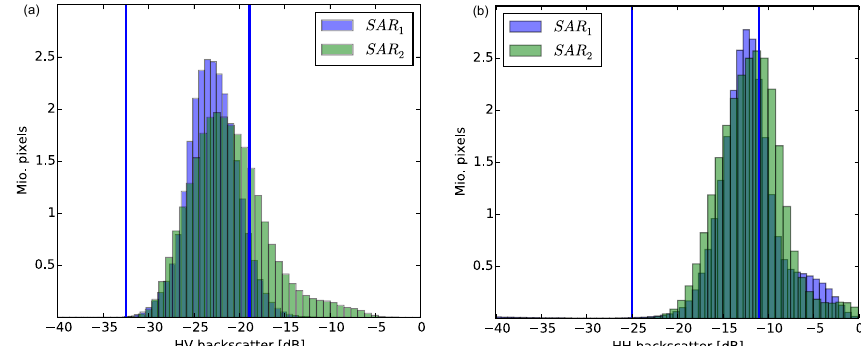
Figure 2. Histogram of (a) HV and (b) HH backscatter values σ 0 from image pair Fram Strait. The lower and upper brightness boundaries =− 32.5dB, σ 0 =− 18.86dB) and HH ( σ 0 =− 25.0dB, σ 0 =− 10.97dB) are shown with blue lines and illustrate the for HV ( σ 0 max max min min domain for the intensity values i .